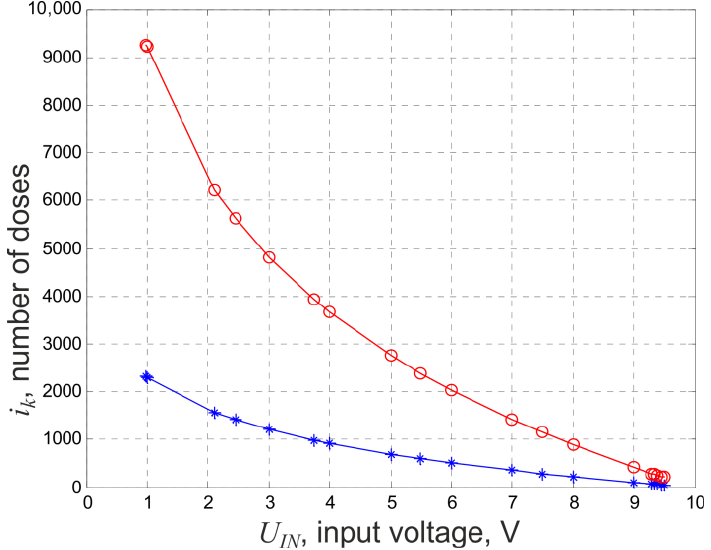
Figure 5. Graphs of processing time of the multifunctional ADCF: 10-bit (blue *) and 12-bit (red o), for five input voltages.